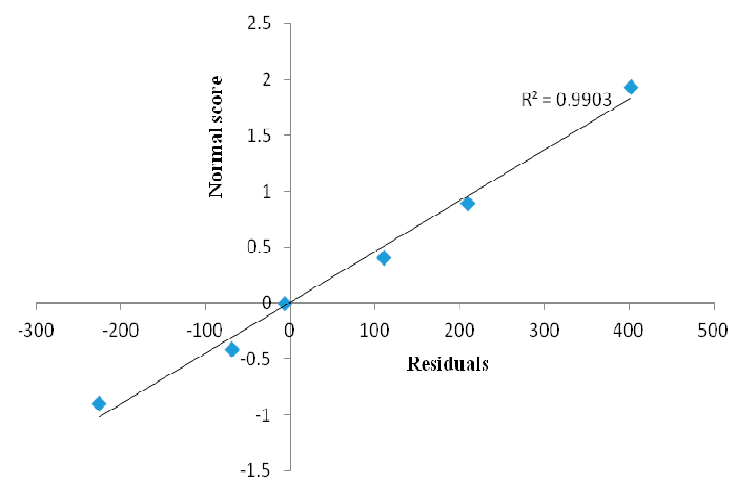
Figure 4. Normal distribution graph between residuals and normal score. Table 1. Densitometric validation summary of betulinic acid.